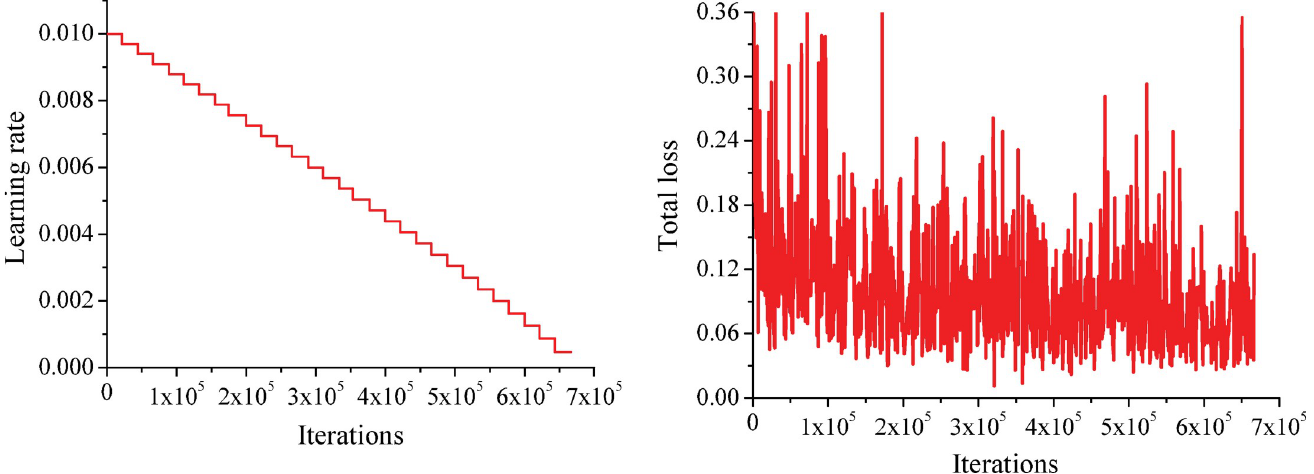
Fig 7. Graphs of the learning rate and total loss. (a) Learning rate. (b) Total loss.